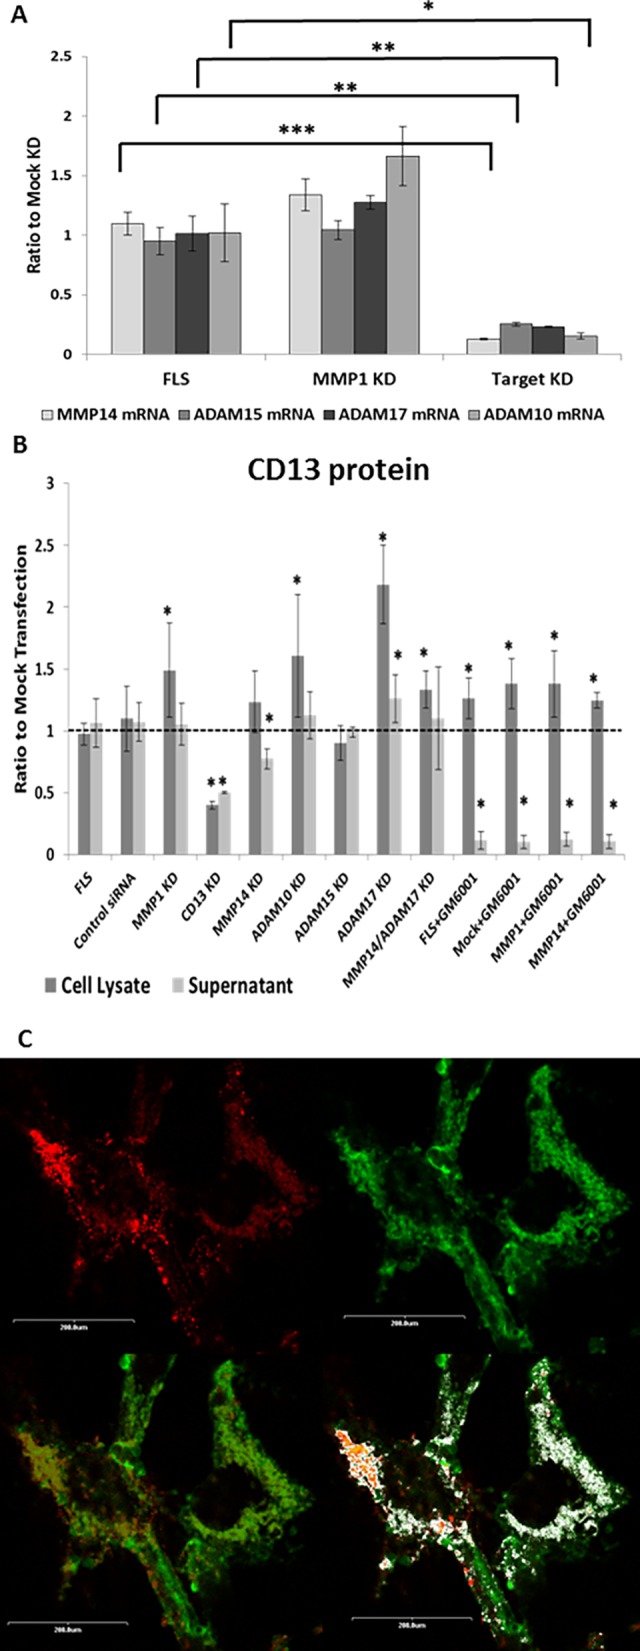
MMP14 knockdown partially inhibits the shedding of CD13 from FLS.(A) MMP14 mRNA was almost completely removed by transfection with MMP14 siRNA. ADAM10, ADAM15, and ADAM17 knockdown constructs each also almost completely removed their respective mRNAs with appropriate siRNA transfection. None of the siRNAs (MMP14, ADAM10, ADAM15, or ADAM17) had an off target effect on MMP1. n = 3 (B) Shedding of CD13 into FLS culture supernatant was inhibited by knockdown of MMP14. Further inhibition was seen with GM6001. CD13 in FLS lysate was not changed by knockdown of MMP14, and significantly increased in GM6001 treated FLS. FLS were grown to confluence then transfected with siRNA using an Amaxa nucleofector kit. Cells were grown to 75% confluence then switched to serum free growth media (Peprogrow) supplemented with 1ng/ml IL-1 and 10ng/ml TNFα for 48 hours with or without 25μM GM6001. (C) Cells were incubated for 1hour at room temperature with anti-CD13-FITC (1D7) 1μg/100μl and anti-MMP14-PE (128527) at 1.67μg/100μl. Figures shown were taken at 1000x. The four panels show: top left, MMP14 alone (red); top right, CD13 alone (green); bottom left, co-localization (co-localization in yellow); and bottom right, co-localization analysis by ImageJ (white = overlapping red and green pixels). All images were background corrected using DAPI alone and MsIg-FITC and MsIg-PE for threshold limits. Representative of n = 6 *p≤0.05 **p≤0.005 ***p≤0.0001 mean±SEM (n≥2)